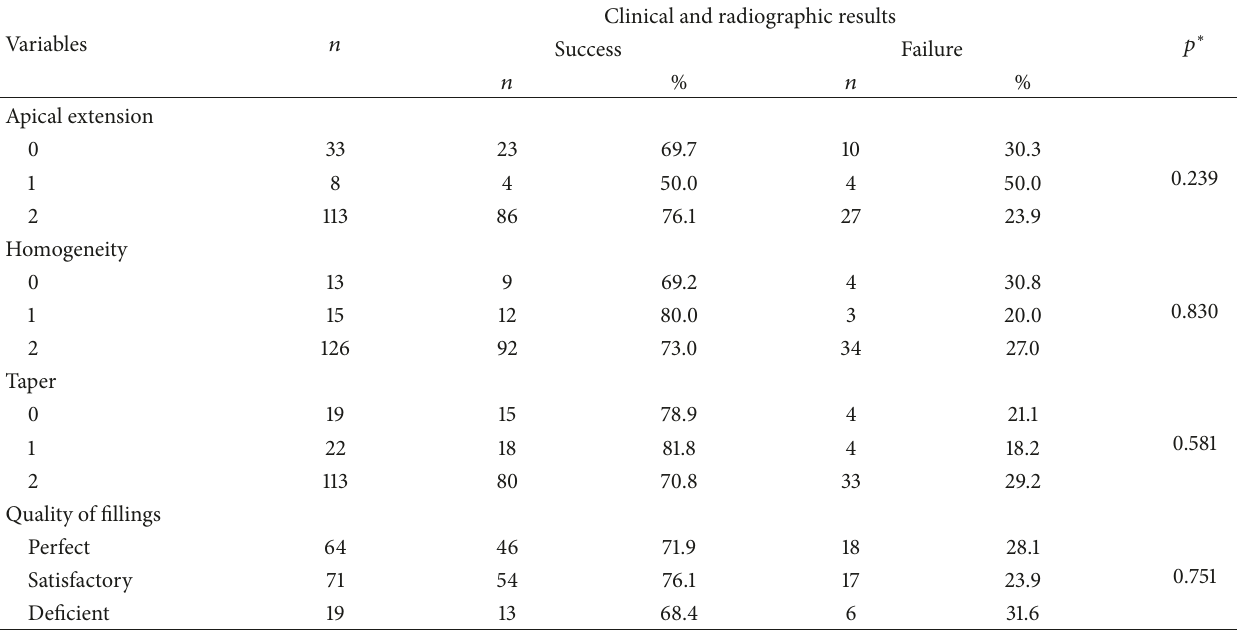
Table 2: Clinical and radiographic success according to filling quality